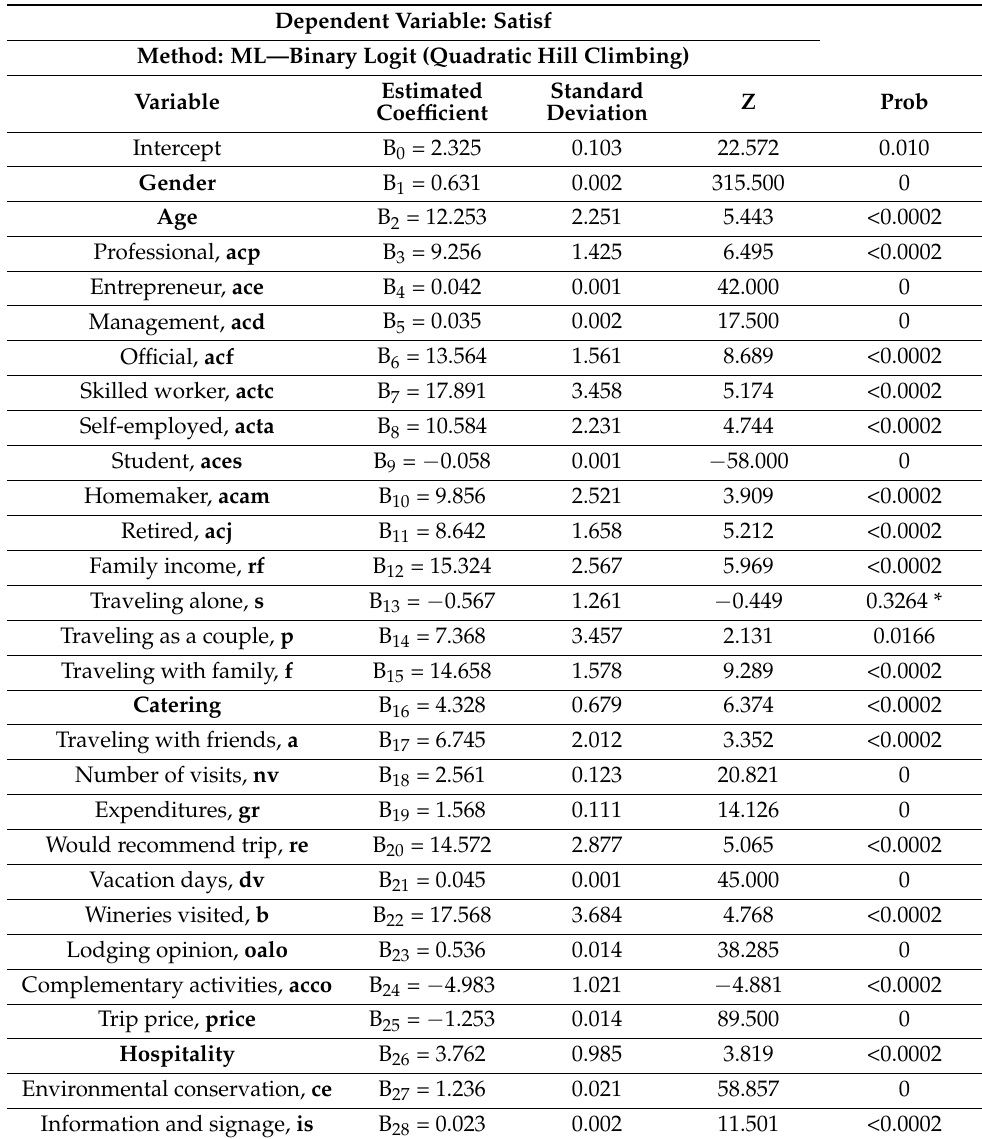
Table 4. Logit model estimation. Dependent Variable: Satisf Method: ML—Binary Logit (Quadratic Hill